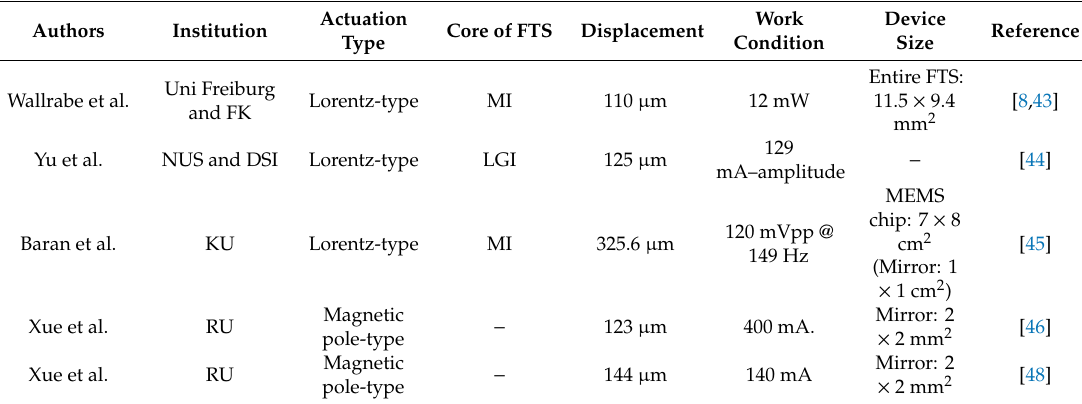
Table 2. Comparison of electromagnetic MEMS micromirrors and FTS.